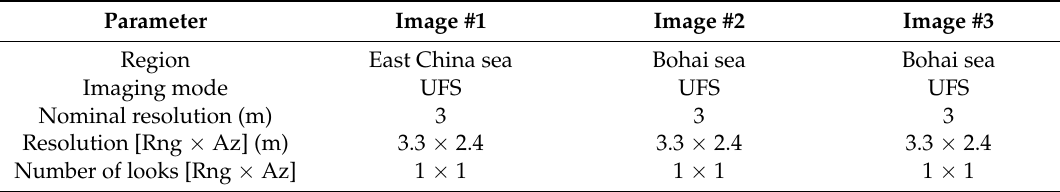
Table 1. The detailed information of the three GF-3 SAR images used in the